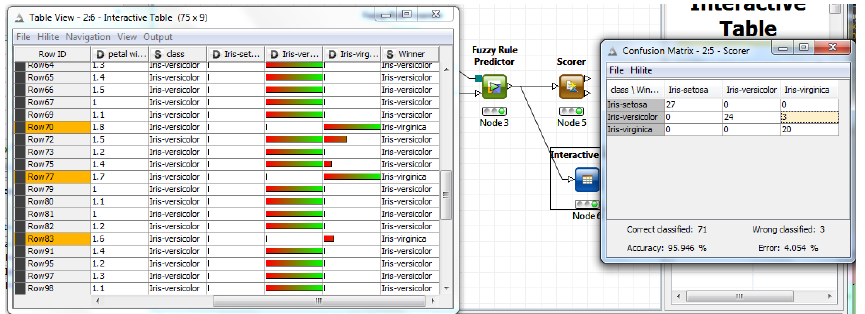
Figure 2: KNIME’s hiliting features demonstrated by the linkage between the confusion matrix and the evalua- tion data.